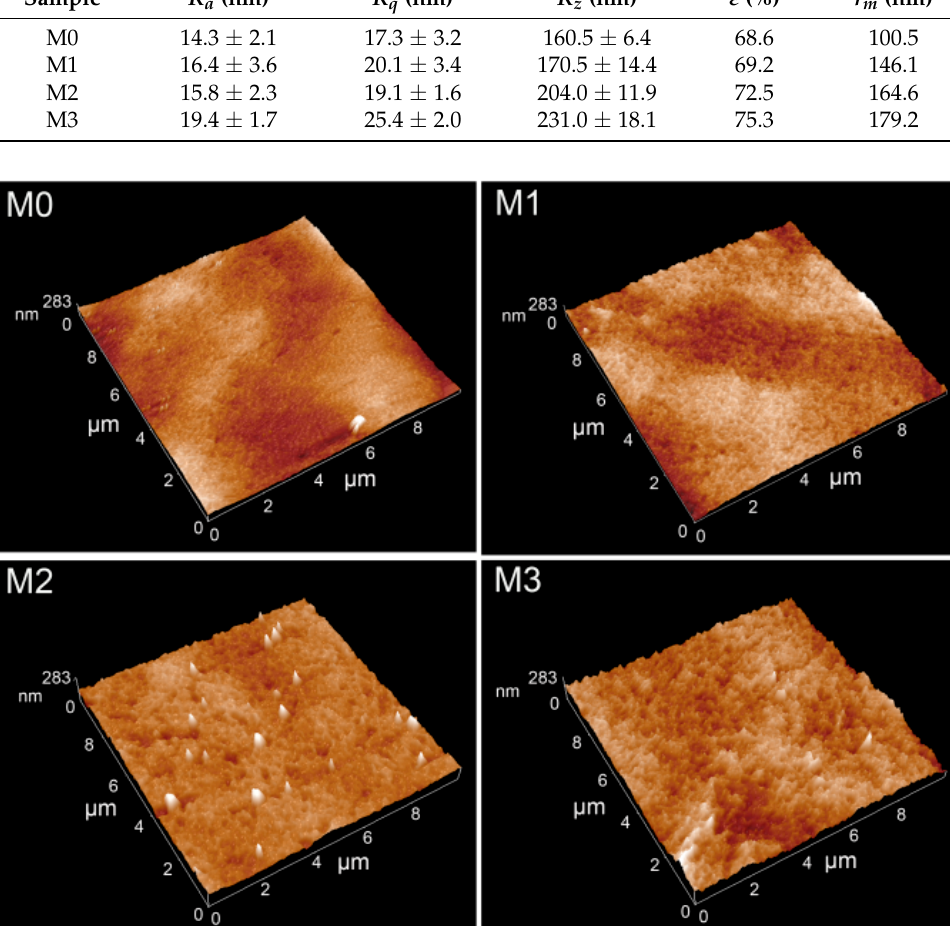
Figure 4. AFM images of membrane surfaces. Table 3. Roughness parameters, porosity and pore sizes of hybrid membranes.